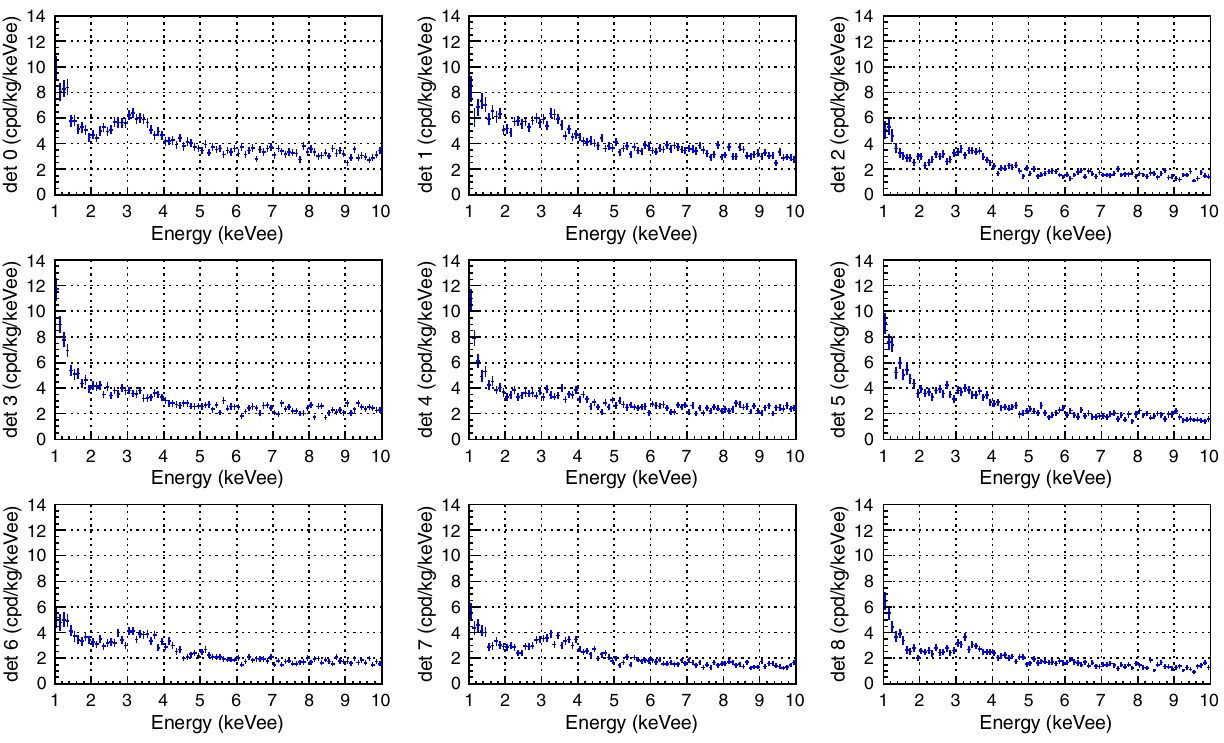
Fig. 2 Anticoincidence energy spectrum measured at low energy after filtering and efficiency correction for each detector, corresponding to the ∼ 10% of the first year of data unblinded